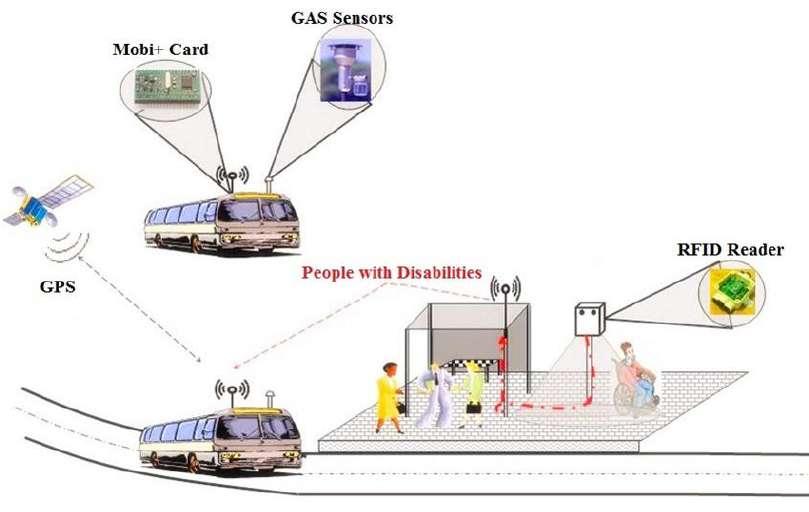
Figure 1. Functional bloc diagram of the Mobi+